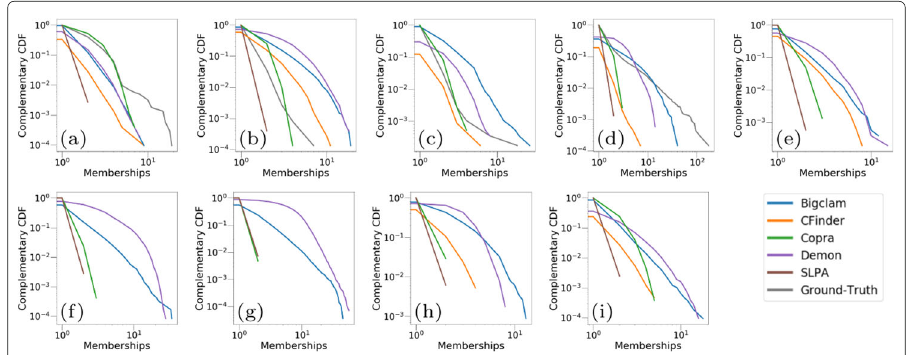
Fig. 6 Memberships of the nodes identified by the methods considering the real-world networks: a Amazon; b DBLP; c LiveJournal; d Youtube; e CAGrQc; f CAHepPh; g CitHepTh; h Email; i